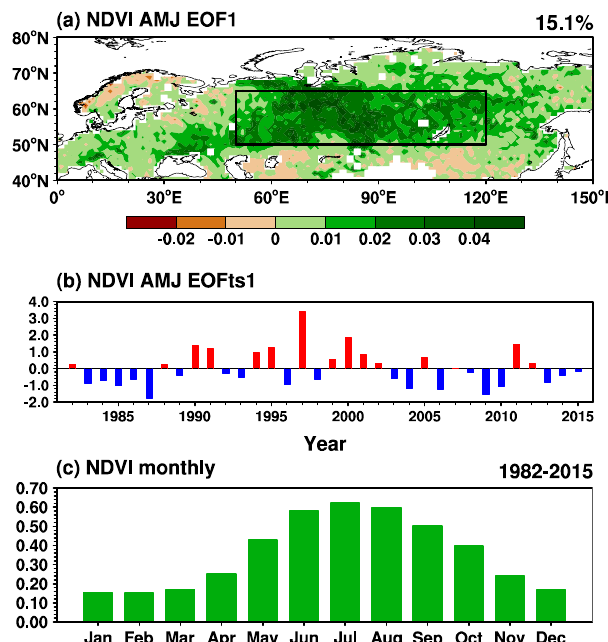
Figure 1. ( a ) The first spatial mode of the EOF of spring (April–May–June (AMJ)) normalized difference vegetation index (NDVI) during 1982–2015. The variance explained by the EOF mode is shown above the top right-hand corner. ( b ) Corresponding time series of the first EOF mode. ( c ) Monthly area-averaged NDVI over (40 ◦ –80 ◦ N, 0 ◦ –150 ◦ E) during